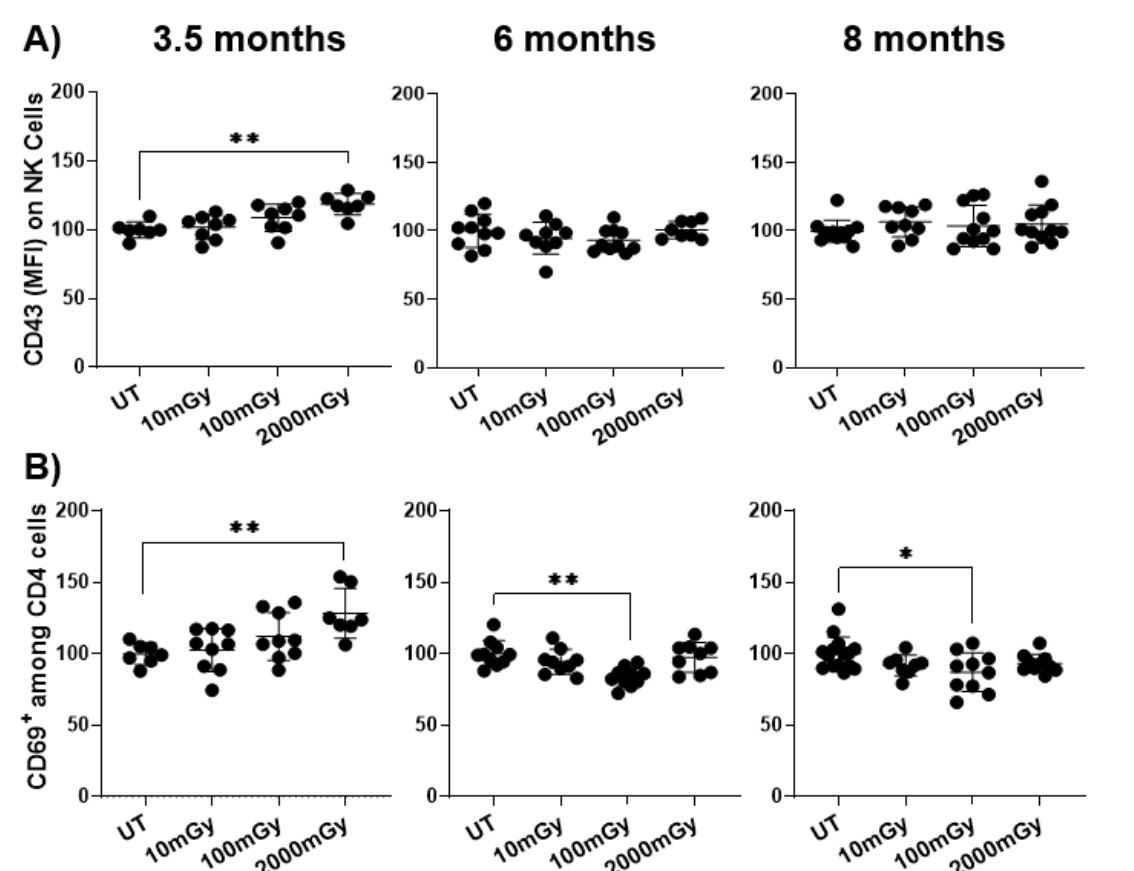
Figure 3. Radiation induces immune cell activation. Splenic lymphocytes from mice sacrificed at indicated points after radiation exposure were used to measure the expression of activation markers. ( A ) Expression of CD43 (activation-associated glycoform) on NK cells and ( B ) expression of CD69 (early activation marker) on CD4+ T were measured by flow cytometry after surface staining. Y-axis in ( A ) represents the relative MFI and ( B ) relative percent of CD4+ cells expressing an activation marker. MFI and percent cells in untreated mice were set to 100%. Data represent mean + SD. * p < 0.05, ** p < 0.01.